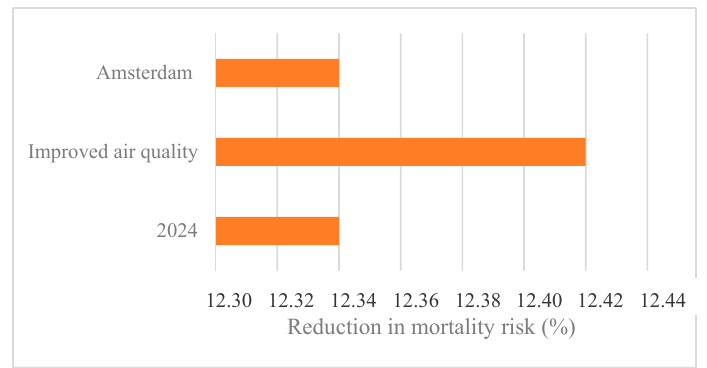
Figure 6. Reduction in mortality risk when travel duration is set equal to 30 min/day.